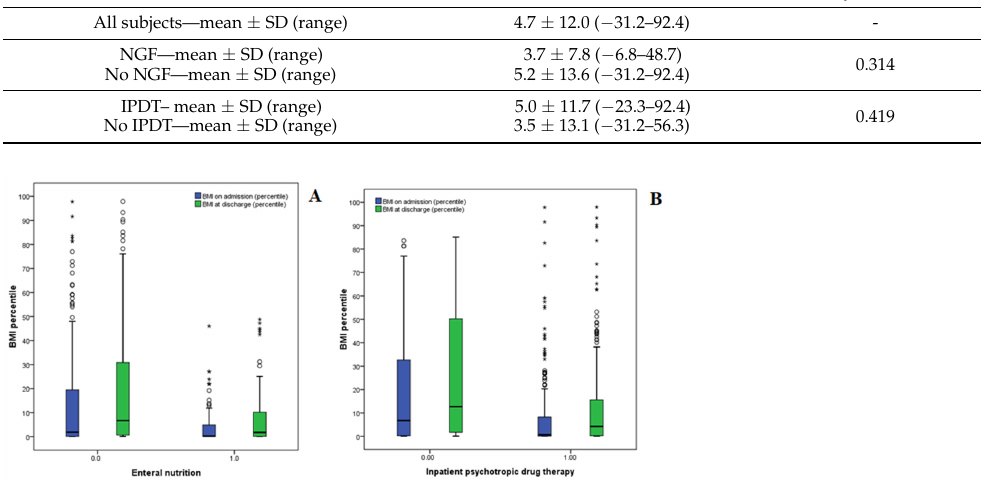
Table 4. Mean BMI percentile differences between admission and discharge (effects of NGF and IPDT).